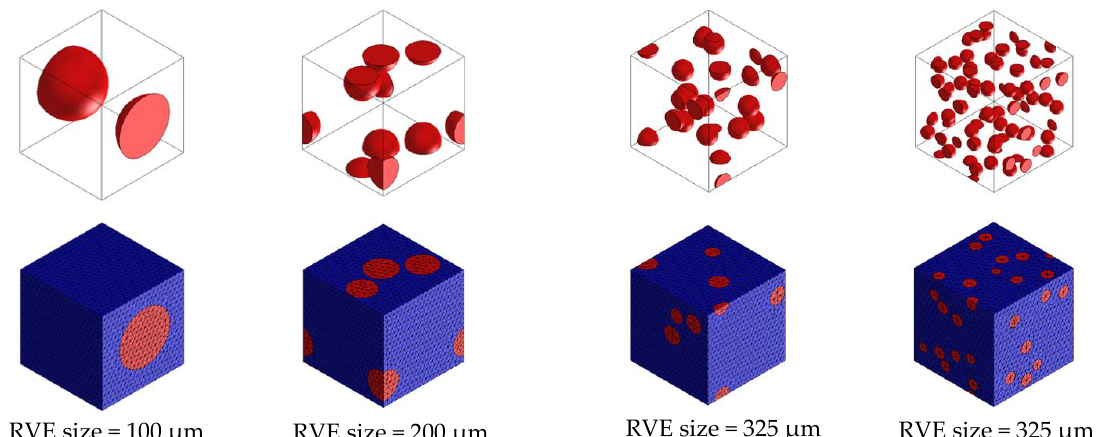
Figure 7. Four difference size RVEs and corresponding mesh models.